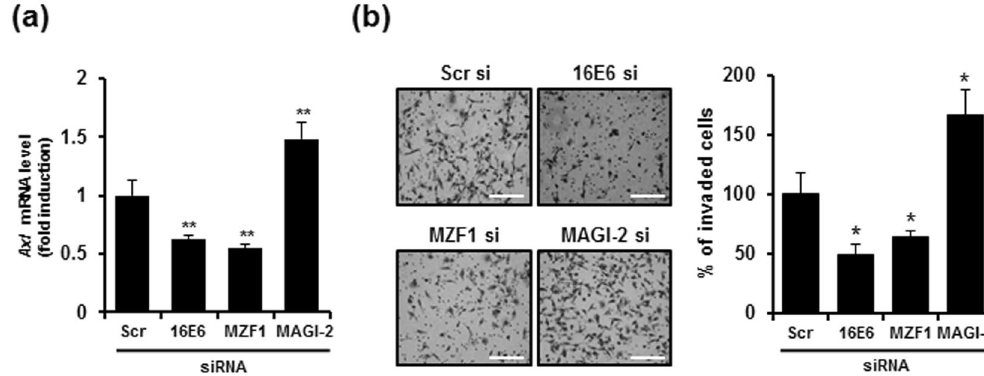
Figure 4. Involvement of MAGI-2 and MZF1 in E6-mediated Axl expression modulates the tumour cell invasiveness. ( a ) Axl expression levels were determined by real-time RT-PCR in HE6F cells transfected with HPV16E6, MZF1, or MAGI-2 siRNA as indicated. ( b ) Representative images of transwell invasion assay after transfection of HE6F cells with HPV16E6, MZF1, or MAGI-2 siRNA. (left panel). Scale bars, 100 μ m. The percentages of invaded cells were calculated from the images in bar graph (right panel). Data in ( a) and (b) are shown as the mean ± s.e.m. ( * P < 0.05; ** P < 0.01; *** P < 0.001). Data are representative of five independent